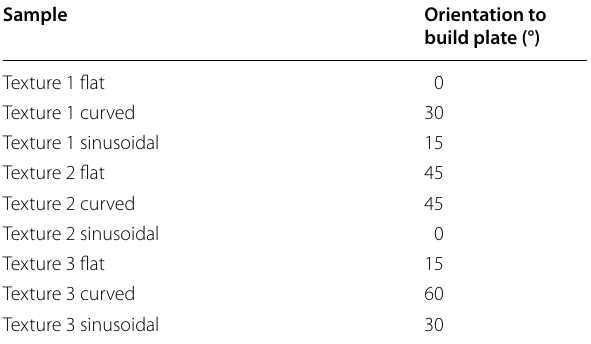
Table 2 FDM sample manufacturing